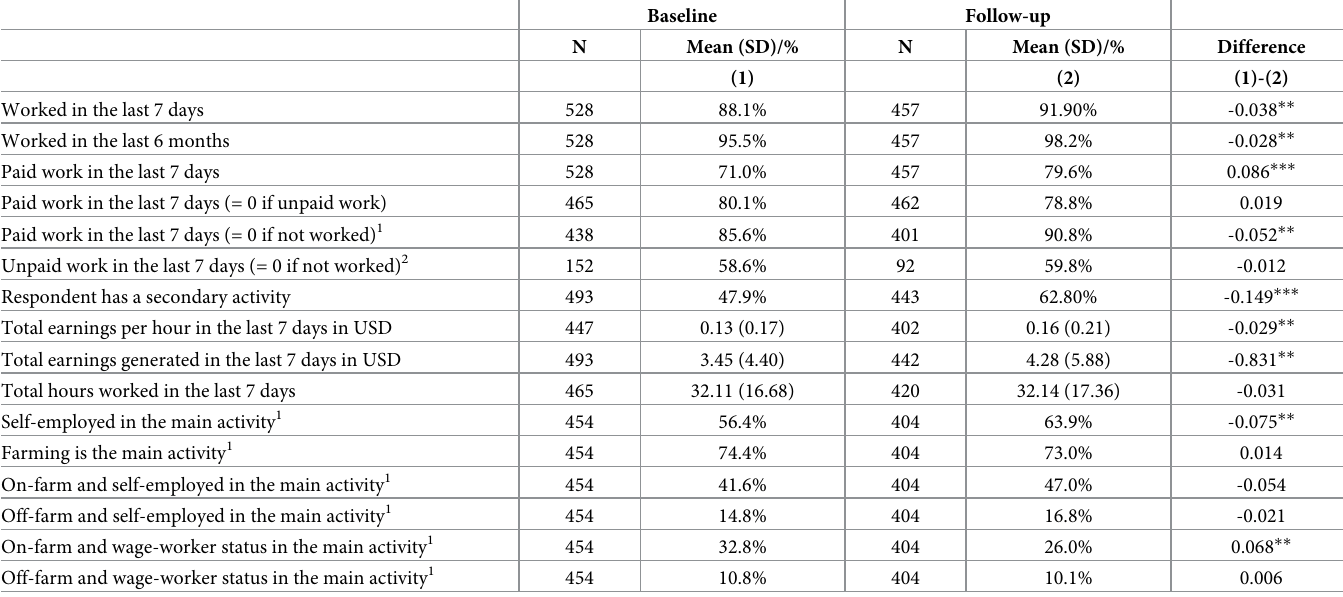
Table 5. Labor market outcomes of interest for the no-therapy subsample at baseline and follow-up.